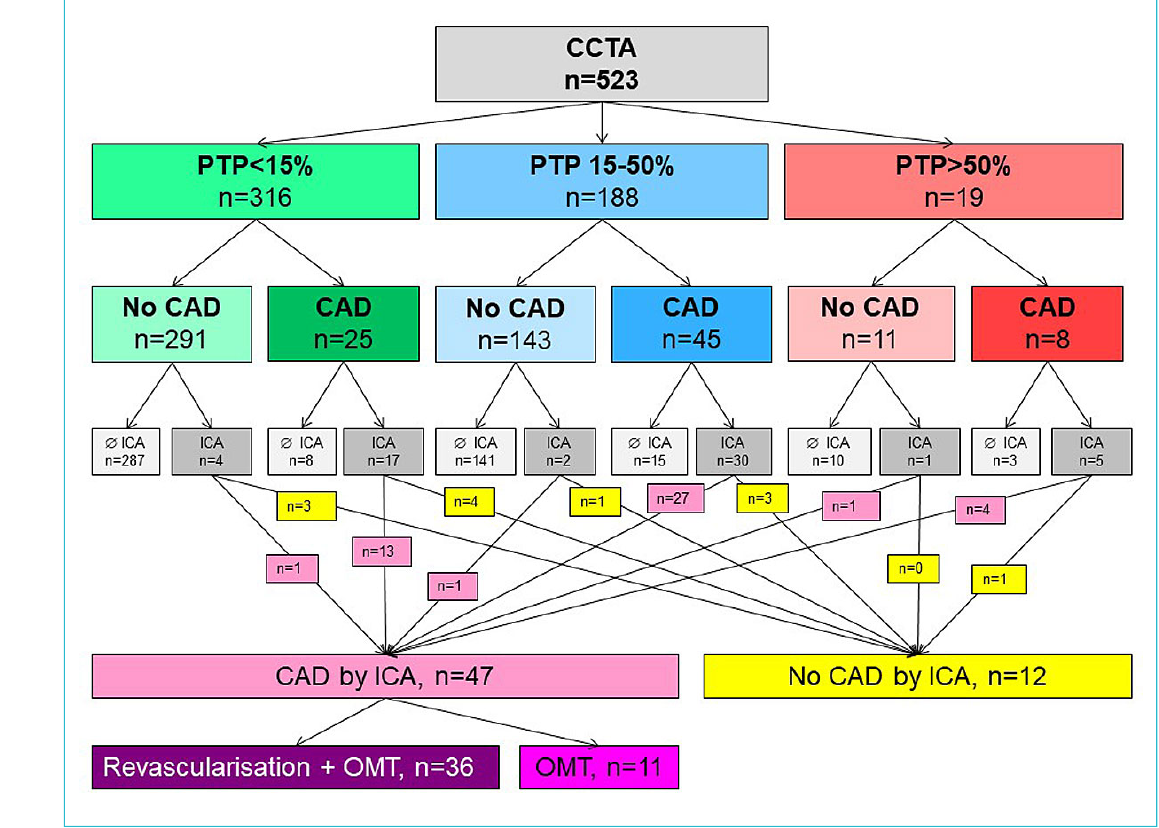
Figure 1: Diagram showing the diagnostic pathway in all patients undergoing coronary computed tomography angiography (CCTA) according to the three pre-test probability (PTP) categories.CAD: coronary artery disease, ICA: invasive coronary angiography, OMT: optimal medical